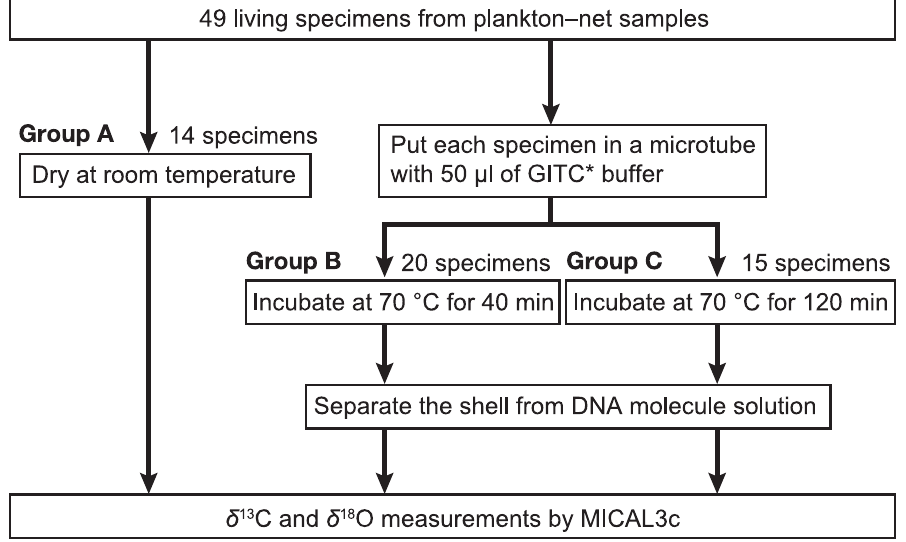
Fig 2. Analytical flowchart for δ 13 C and δ 18 O measurements combined with genetic analyses. We used a mass spectrometer for isotopic analysis of the shells (MICAL3c).